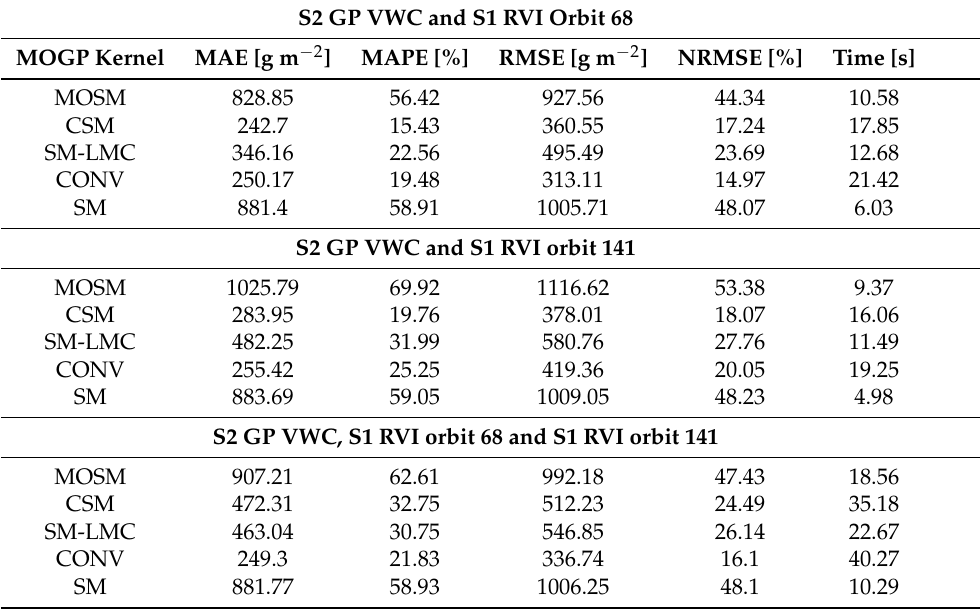
Table 2. Error metrics and training time of the MOGP and SOGP evaluated kernels for the 2020 winter wheat averaged